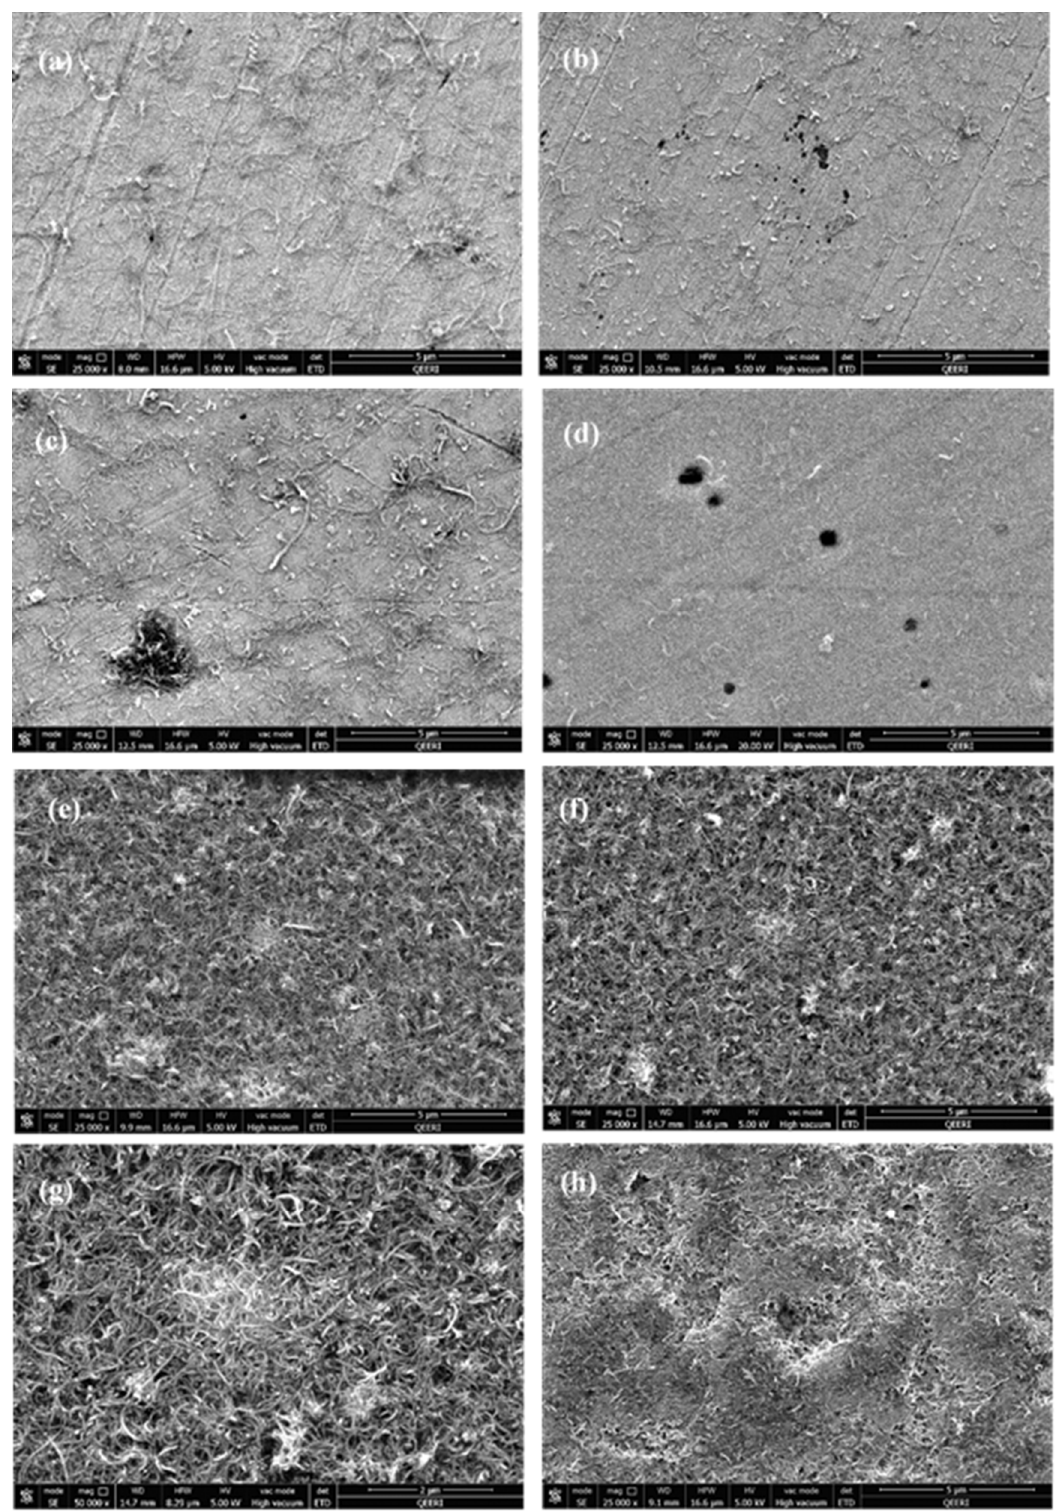
Figure 7. SEM images before washing for 316L stainless steel samples tested in ( a – d ) 0.1 wt.% CNT-water nanofluids at ( a ) 22 ◦ C ( b ) 40 ◦ C ( c ) 60 ◦ C ( d ) 80 ◦ C. Figure ( e – h ) tested in 1.0 wt.% CNTs–water nanofluids at ( e ) 22 ◦ C ( f ) 40 ◦ C ( g ) 60 ◦